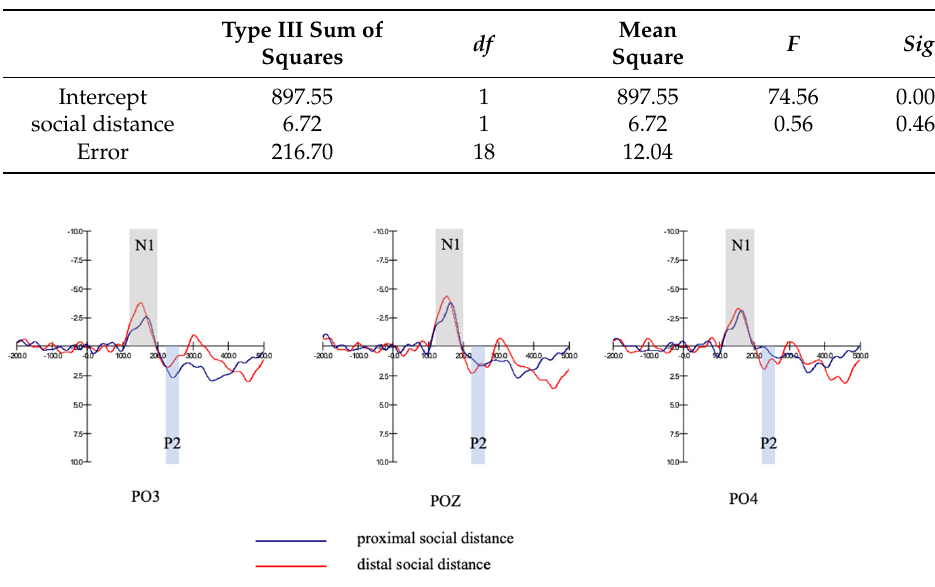
Figure 3. N1, P2 amplitudes of different social distance groups (promotion focus group).